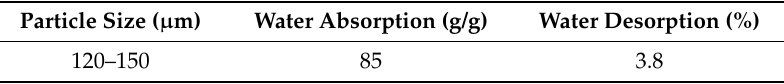
Table 3. Properties of the superabsorbent